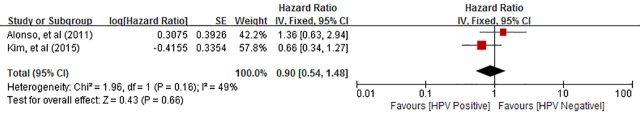
Forest plot for the association between human papillomavirus and disease-free survival in patients with vulvar cancer.